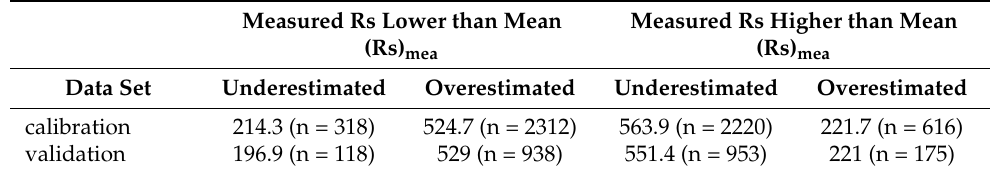
Figure 12. Solar radiation estimated by proposed model at San Martin station versus measured values in calibration and validation sets. Table 18. RMSE values (J · cm − 2 · day − 1 ) and number of data points belonging to under- and over- estimation sets for measured solar radiation less or higher than mean (Rs) mea in calibration and validation phases using proposed model.